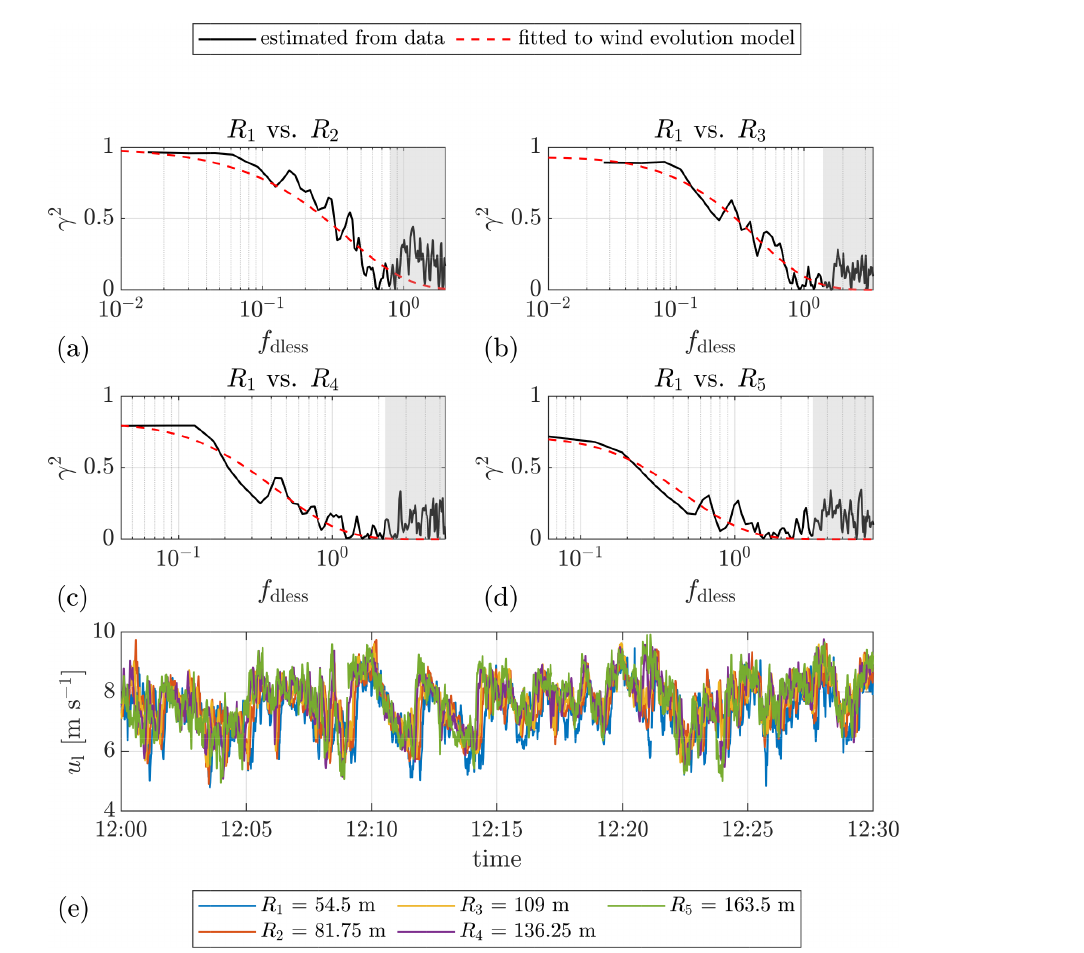
Figure 5. (a–d) Example plots of the estimated coherence between the lidar wind speeds measured at different range gates and the corre- sponding fitted curves. The separations between the corresponding range gates are 27.25, 54.5, 81.75, and 109m, respectively. The shaded areas indicate the data filtered by the cutoff frequency of 0.2Hz. (e) Time series of the lidar wind speed. The mean lidar wind speed U l ranges from 7.3 to 7.7ms − 1 , and the lidar-measured turbulence intensity I T , l ranges from 0.10 to 0.12, for different range gates. Date: 7 December 2013. Data source: Lidar